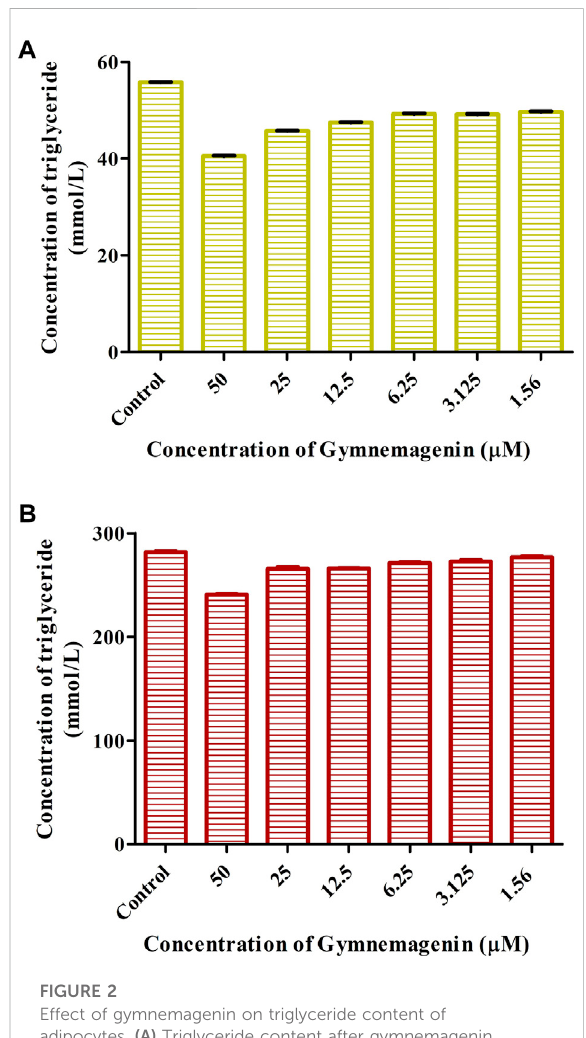
FIGURE 2 Effect of gymnemagenin on triglyceride content